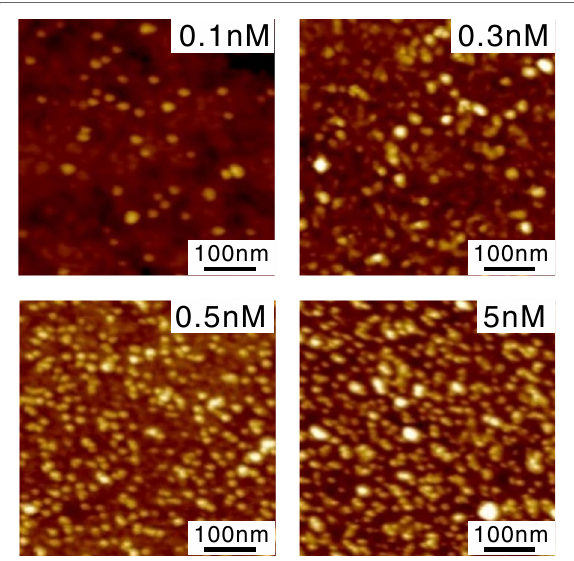
Fig. 3 AFM images of QDs on the flat Au surface. The concentrations of QD solution were 0.1, 0.3, 0.5, and 5